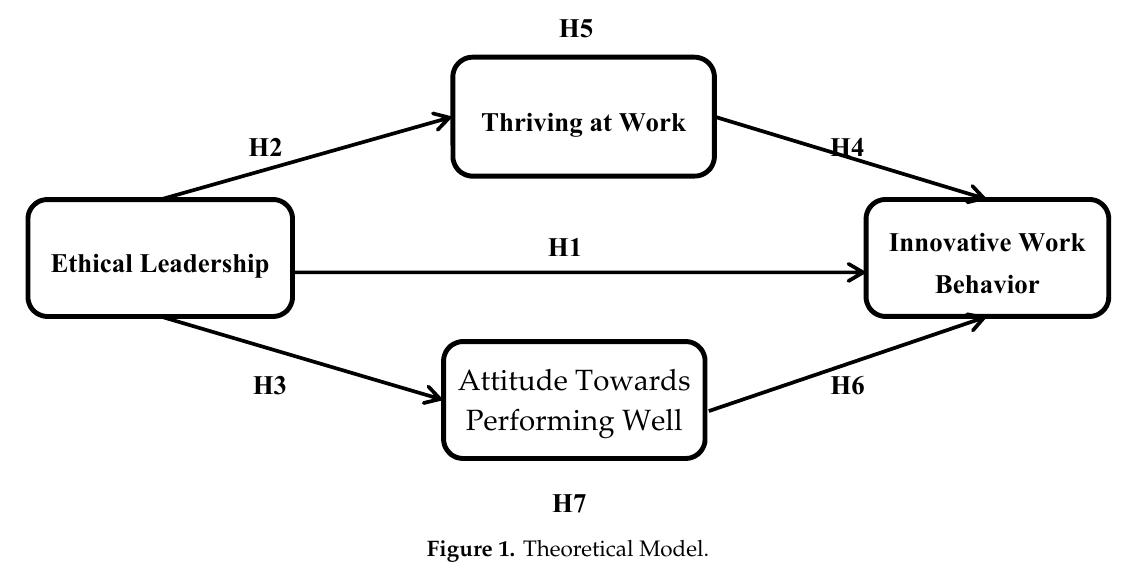
Figure 1. Theoretical Model.